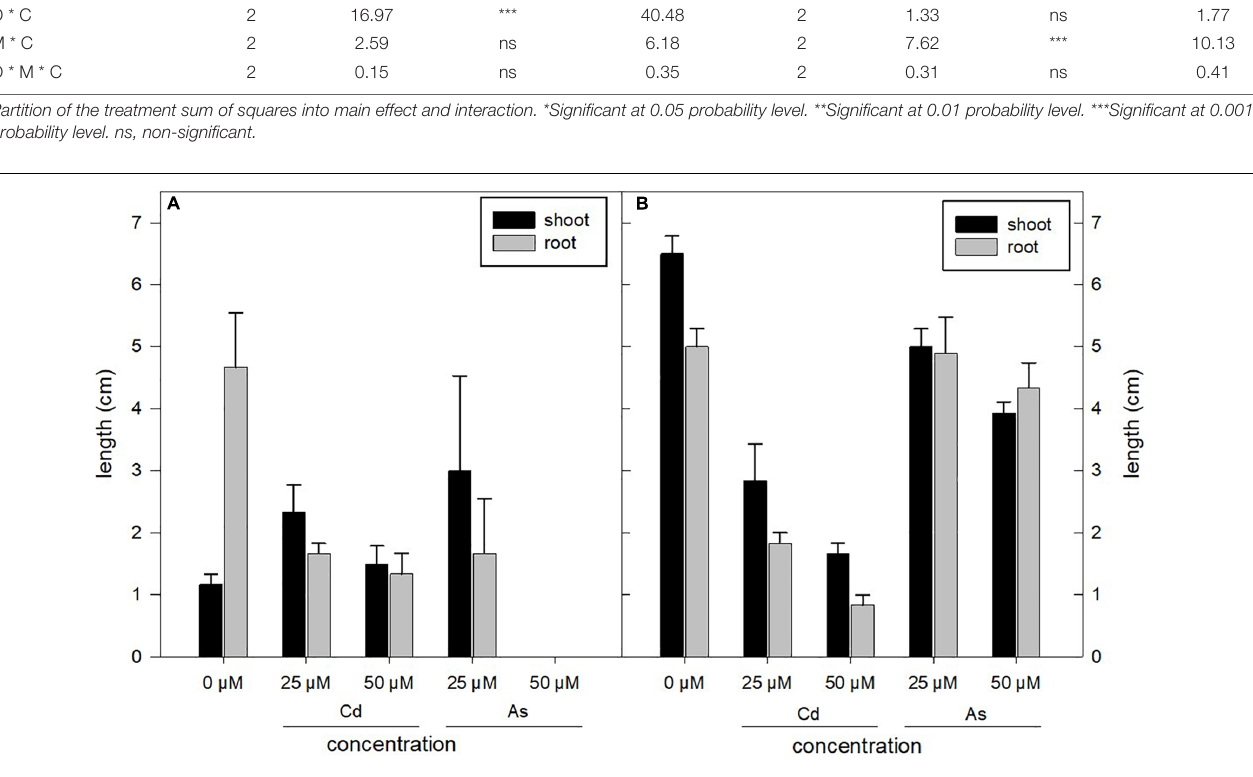
Frontiers in Plant Science |